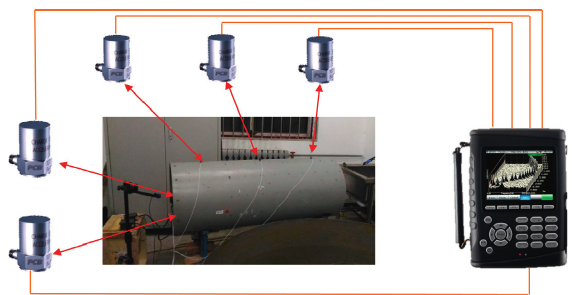
Figure 27: Layout of the experiment varying the receiver’s distance. Table 5: Simulation